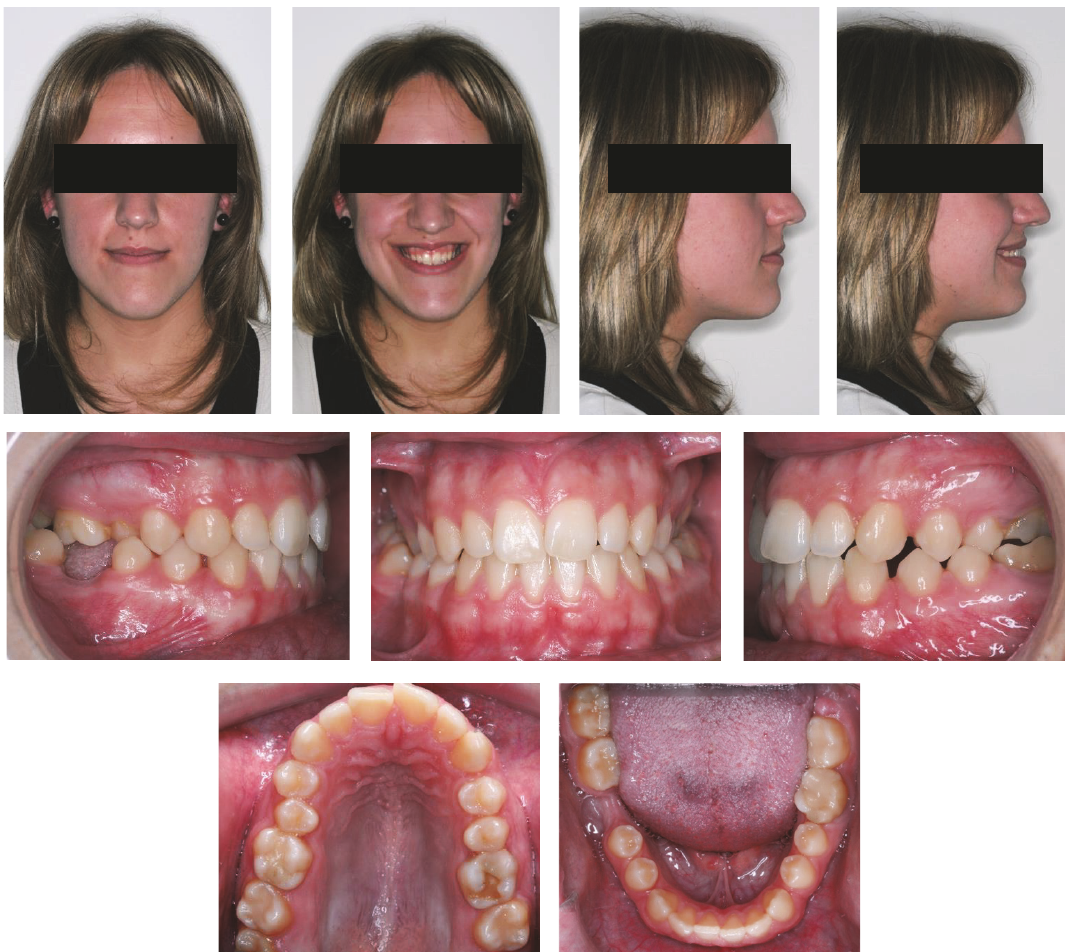
Figure 1: Intra- and extraoral initial